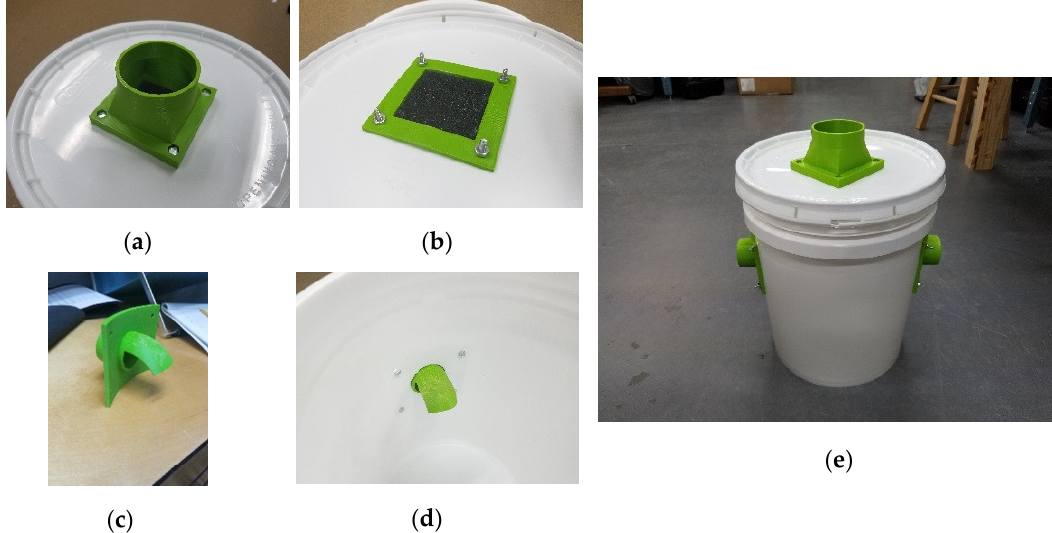
Figure 3. 3D printed parts for the bucket; ( a ) lid with outlet fitting, ( b ) bottom of lid with filter material, ( c ) inlet to bucket design to divert cotton downwards, ( d ) inlet port viewed from the inside bucket, and ( e ) the complete collection bucket.